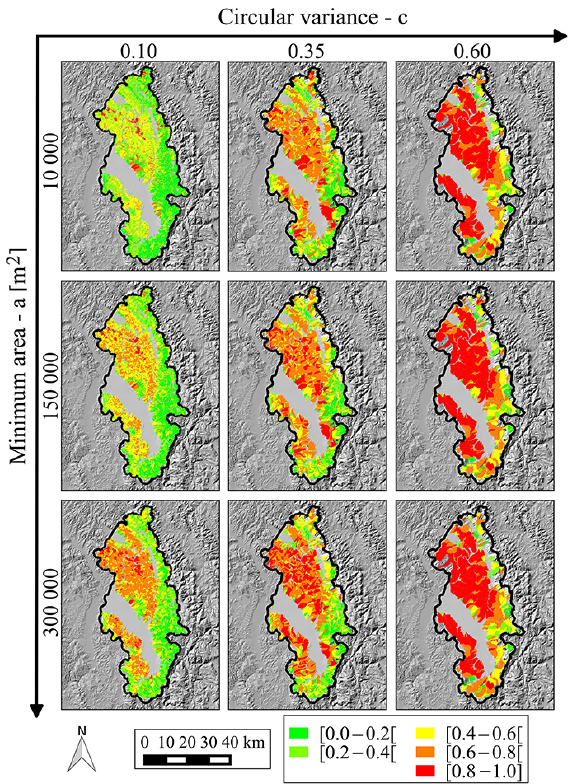
Figure 10. The group of 9 (out of 99) LS maps obtained with dif- ferent SU partitions resulting from different combinations of the a and c parameters. The maps are in the UTM zone 32, datum ED50 (EPSG:23032) reference system.